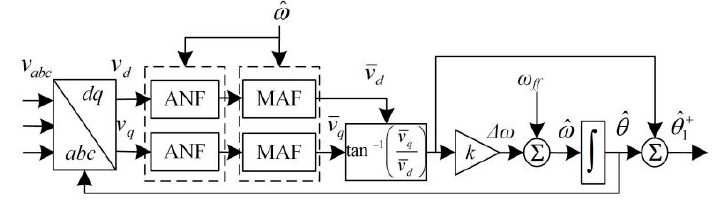
Figure 4. Block scheme of the proposed PLL.